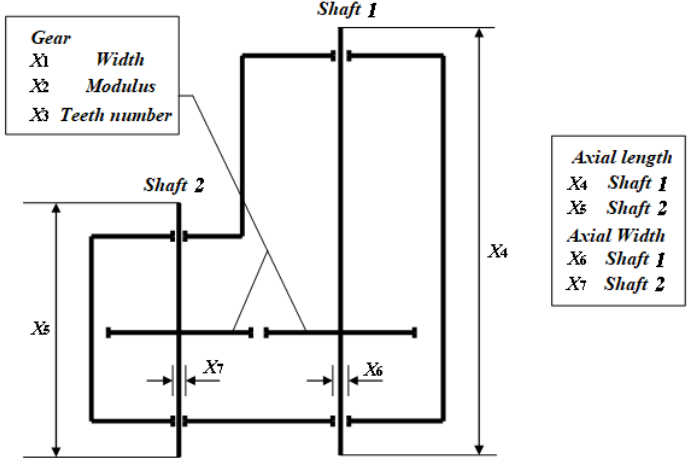
Figure 8. Structural diagram of the reducer.